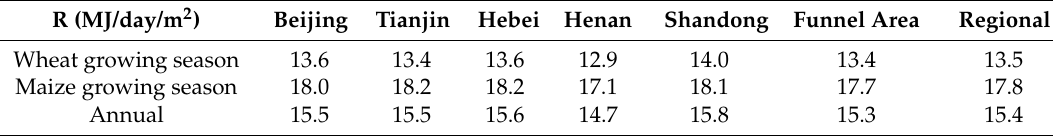
Figure 4. The spatial distribution of the long-term average daily solar radiation (R) for ( a ) the winter-wheat growing season; ( b ) the summer-maize growing season and ( c ) the annual basis. Table 3. The province-wide, funnel area, and regional statistics for wheat, maize, and the annual average daily solar radiation.